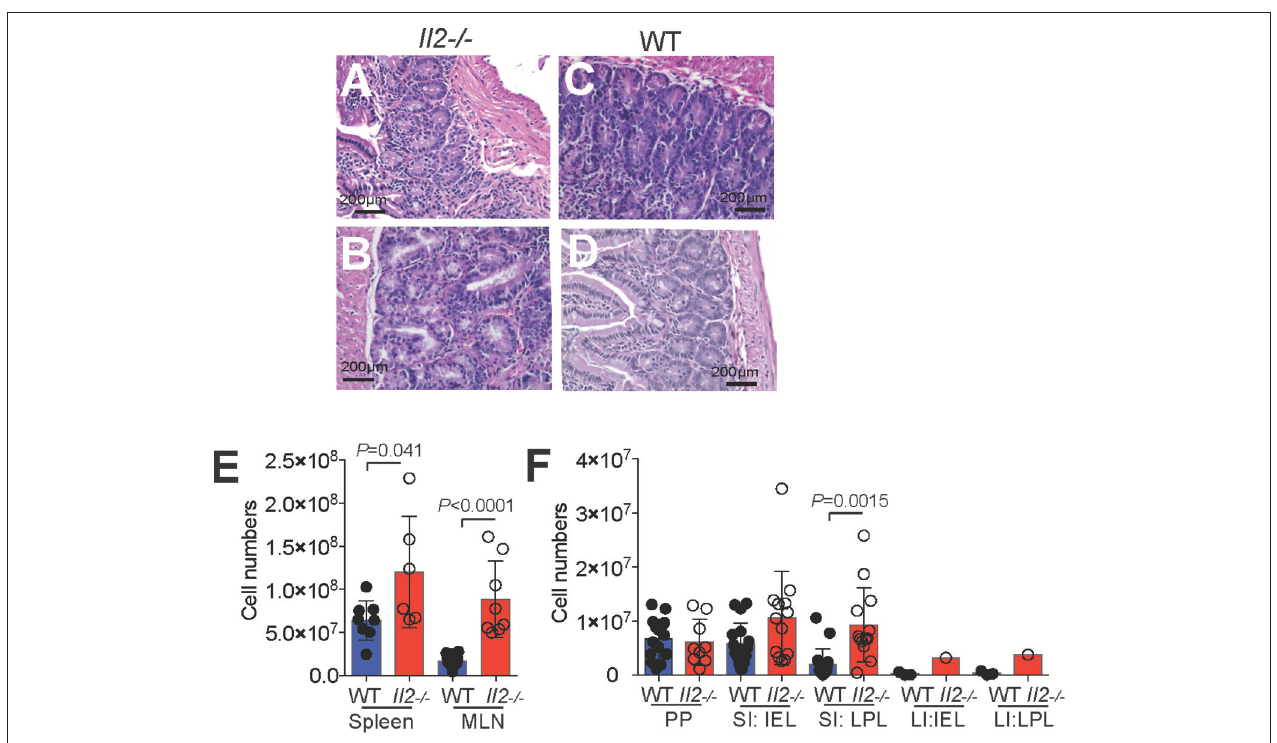
FIGURE 1 | Inflamed bowel and numeration of leukocytes in Il2 − / − mice. Representative histological sections of intestinal tissues from Il2 − / − mice (A,B) and WT mice (C,D) mice stained with hematoxylin and eosin, optical microscope 40X. (E,F) FACS analyses and cell counts were used to determine numbers of CD45 + cells in Il2 − / − and WT mice, cell numbers were normalized to organ weight. Data shown as mean ± SEM ( n = 3-9) and analyzed by Students T